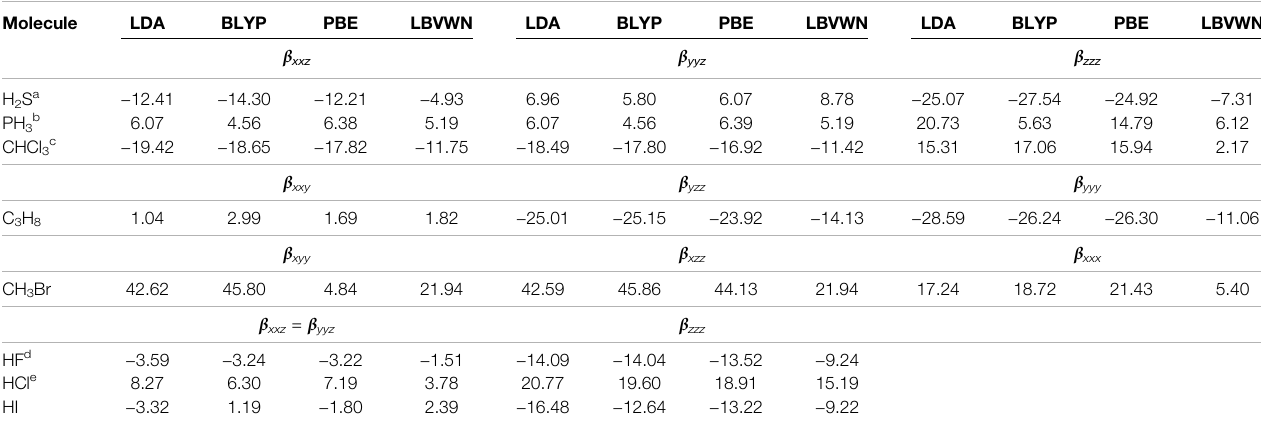
TABLE 4 | The components of β for some selected molecules for four XC functionals. All results are in a.u. See Mandal et al. (2019) for details. Molecule LDA